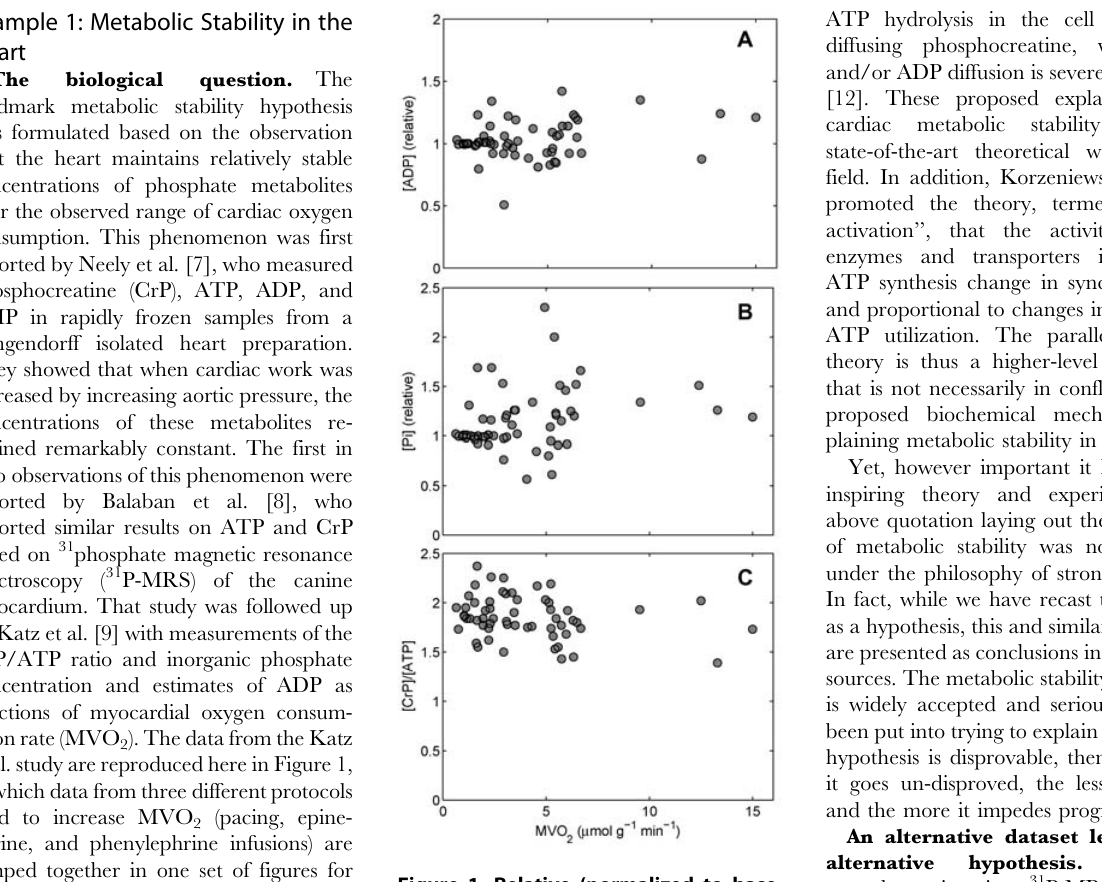
Figure 1. Relative (normalized to base- line) cardiac [ADP], [Pi], and [CrP]/[ATP] versus cardiac oxygen consumption rate (MVO 2 ) from Katz et al. [ 9 ] . (A) [ADP], (B) [Pi], (C) [CrP]/[ATP]. Data were obtained from 31 P-MRS of the canine myocardium, with MVO 2 varied by pacing or infusion of epi- nephrine or phenylephrine. Data are